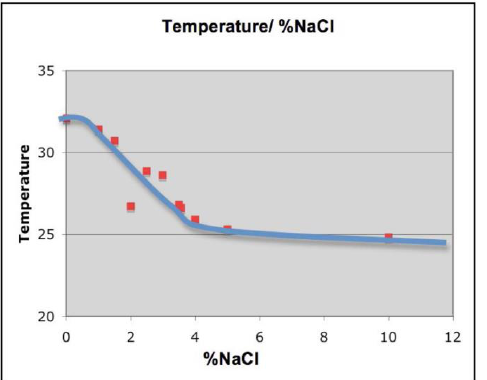
Figure 3. Effect of adding different concentrations of NaCl on melting temperature of PCM. In the absence of NaCl, the melting point (red) is 32 °C. Adding increasing amounts of NaCl decreases the melting temperature to approximately 25 °C when 5% NaCl is added. Further additions of NaCl do not appear to cause further decrease of the melting point. The approximated curve (blue) does not illustrate the possibility that there may be further complexity of the melting point temperatures in the 1.5 – 3.0% NaCl range, due to the technical limitations of our experimental set up. However, the correlation is significant.